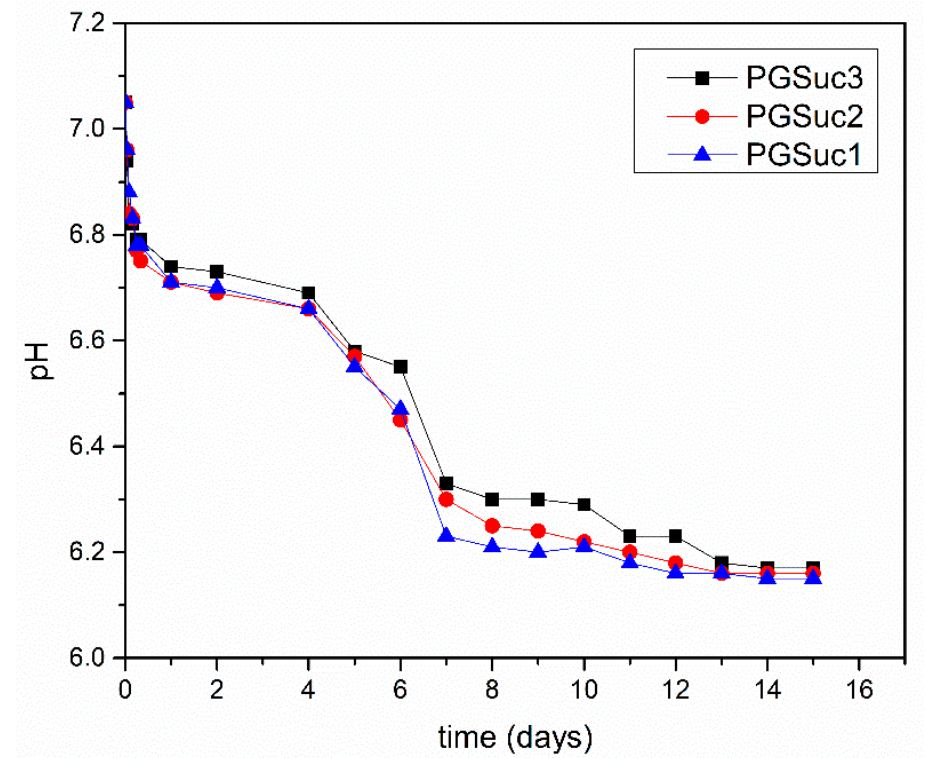
Figure 3. Hydrolytic degradability of PGSuc samples .